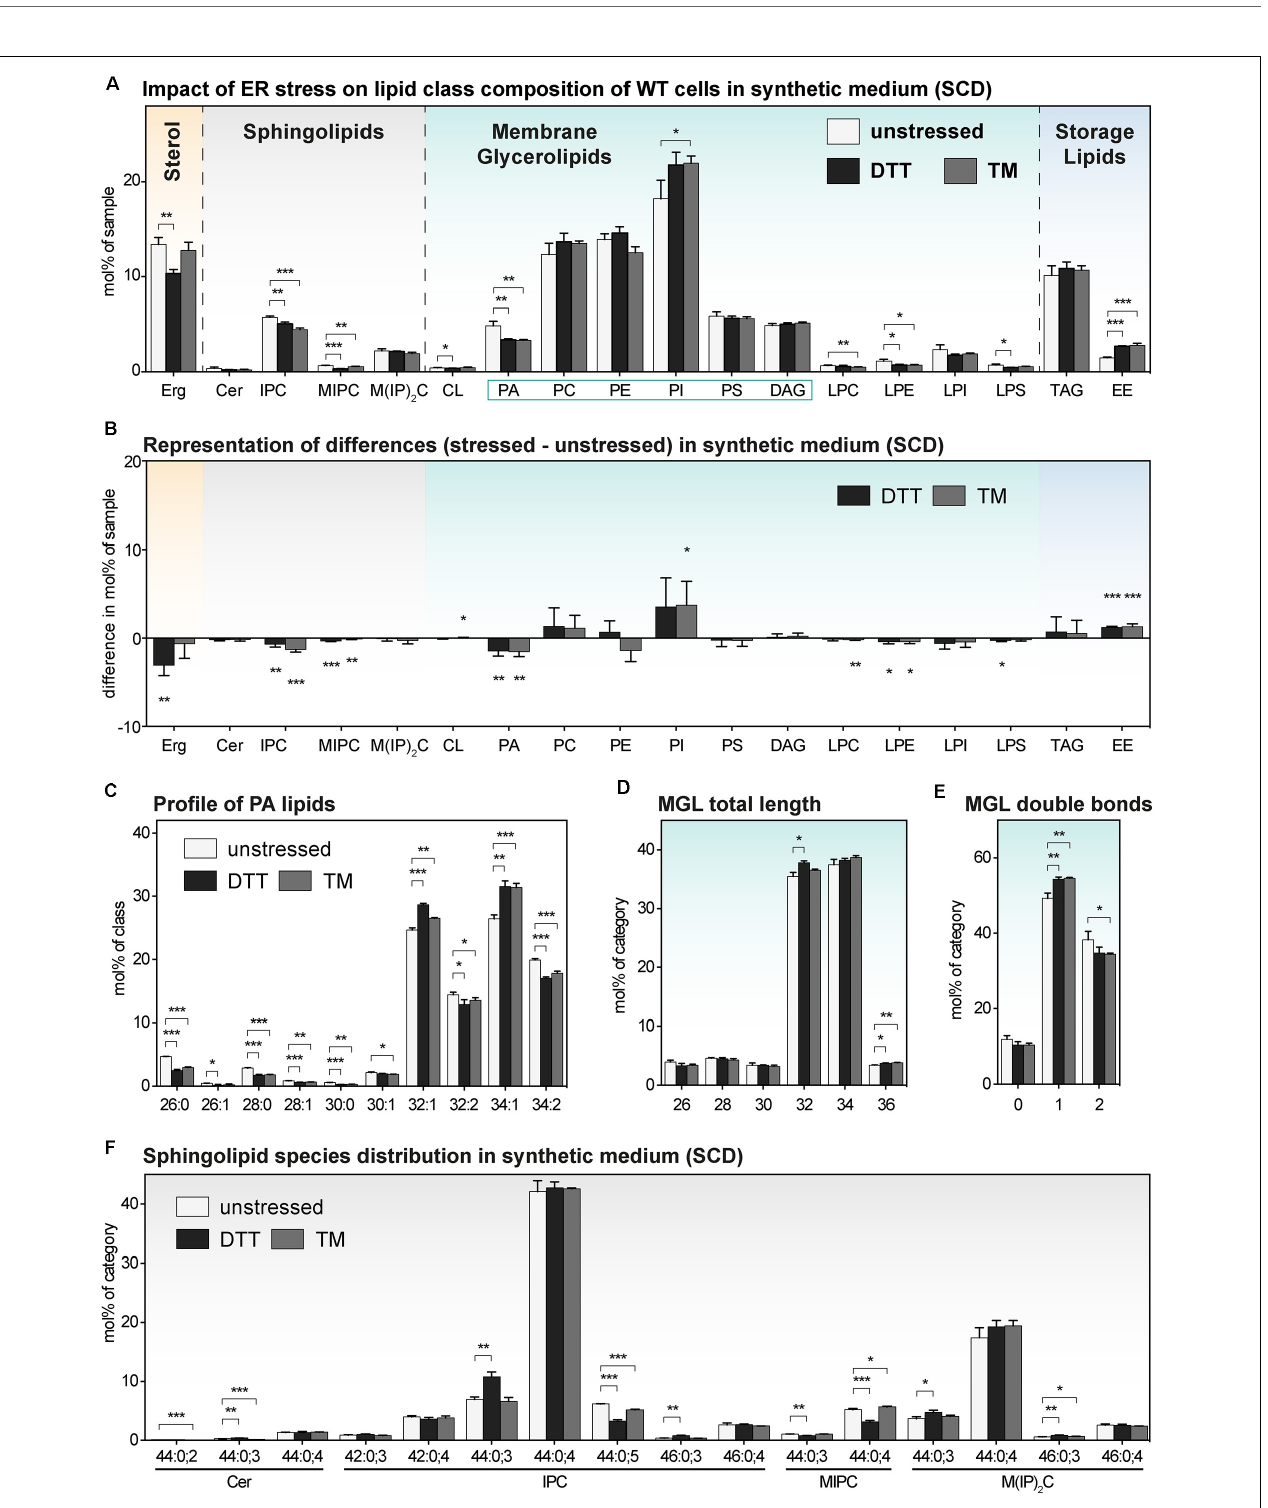
FIGURE 5 | The impact of proteotoxic stress on the lipidome of S. cerevisiae WT cultivated in synthetic medium. A single colony of the BY4741 WT strain was used to inoculate a preculture in synthetic medium (SCD). After overnight cultivation for 21 h, a fresh culture was inoculated to an OD 600 of 0.1 and then cultivated to an OD 600 of 0.80 ± 0.05. The cells were then either left untreated (white bars), stressed by the addition of either with 8 mM DTT (black bars) or 1.0 µ g/ml TM (gray bars). After one additional hour of cultivation, 20 OD equivalents of these cells were harvested and analyzed by lipid mass spectrometry. (A) Lipid class composition in mol% of all quantified lipids in the sample organized by lipid categories. (B) The difference in lipid class abundance in stressed minus unstressed cells highlights